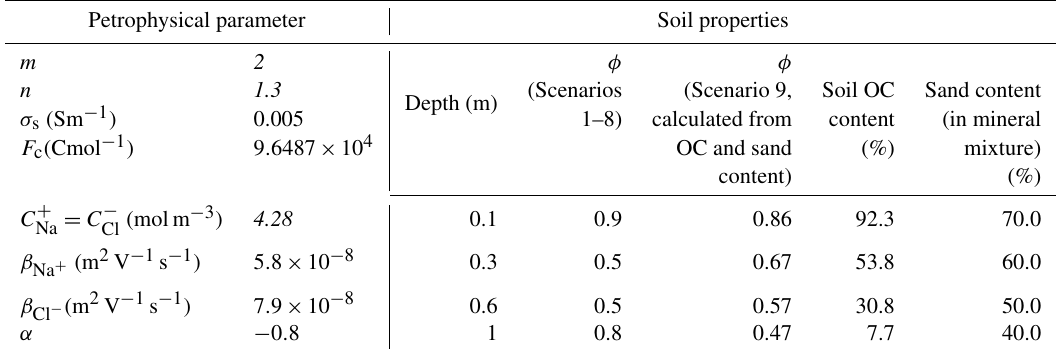
Table 1. Petrophysical parameters and soil properties information used for synthetic simulation. Petrophysical parameters F c , C + β + and β − are obtained from Minsley et al. (2015). Soil OC and sand content are based on the core sample analysis at the site near Barrow, Na Cl AK. The sand content is the percentage of sand in the mineral mixture, which is calculated as 100 minus OC content. The soil porosity is independent from soil OC and sand content for scenarios 1–8, while it is calculated from these properties in scenario 9.